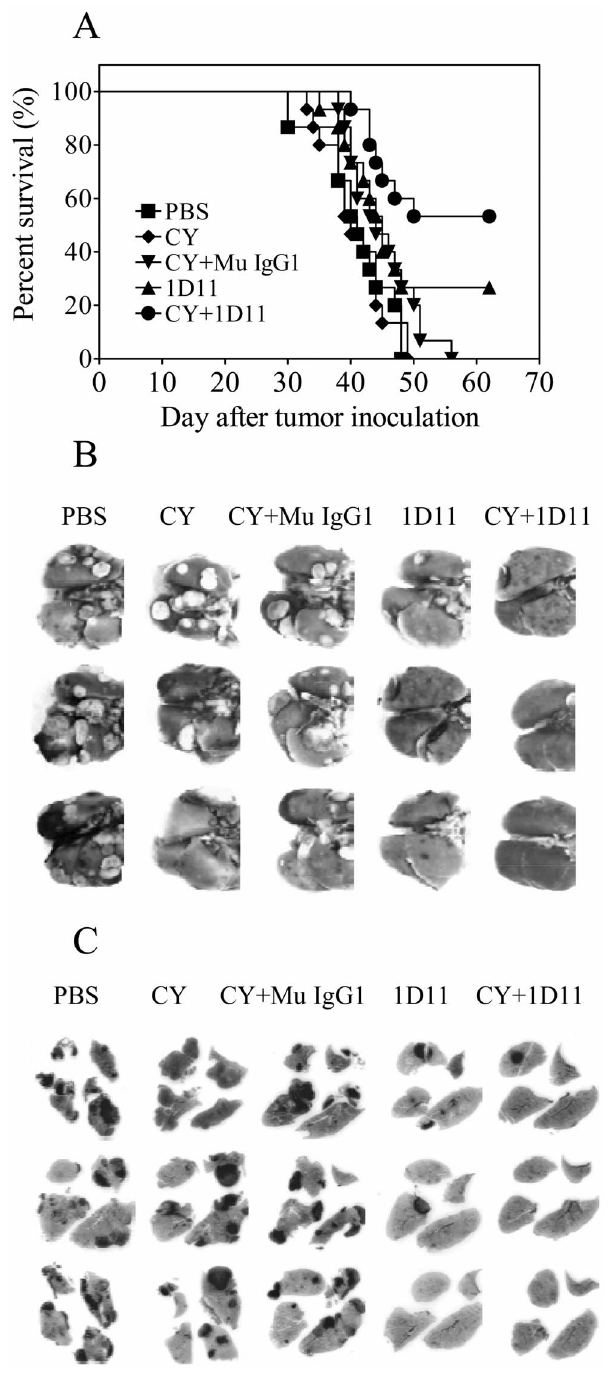
Figure 6. Combination treatment of 1D11 and CY increases survival of mice with 4T1 lung metastasis in an orthotopic implantation/resection format. 4T1 cells were inoculated into the mammary fat pad and primary tumors were surgically removed at day 12 after inoculation. 1D11 or Mu IgG1 (13C4) control antibody (5 mg/ Kg, i.p.) were administered three times per week for the first two weeks and followed by once a week, starting from 7 days after tumor inoculation. A single subtherapeutic dose of CY (50 mg/Kg, i.p.) or vehicle was given on day 14, two days following surgical resection of the primary tumor. The therapeutics was treated alone or combined as indicated. (A) Survival curves for the different treatment groups. Survival curves are significantly different between the